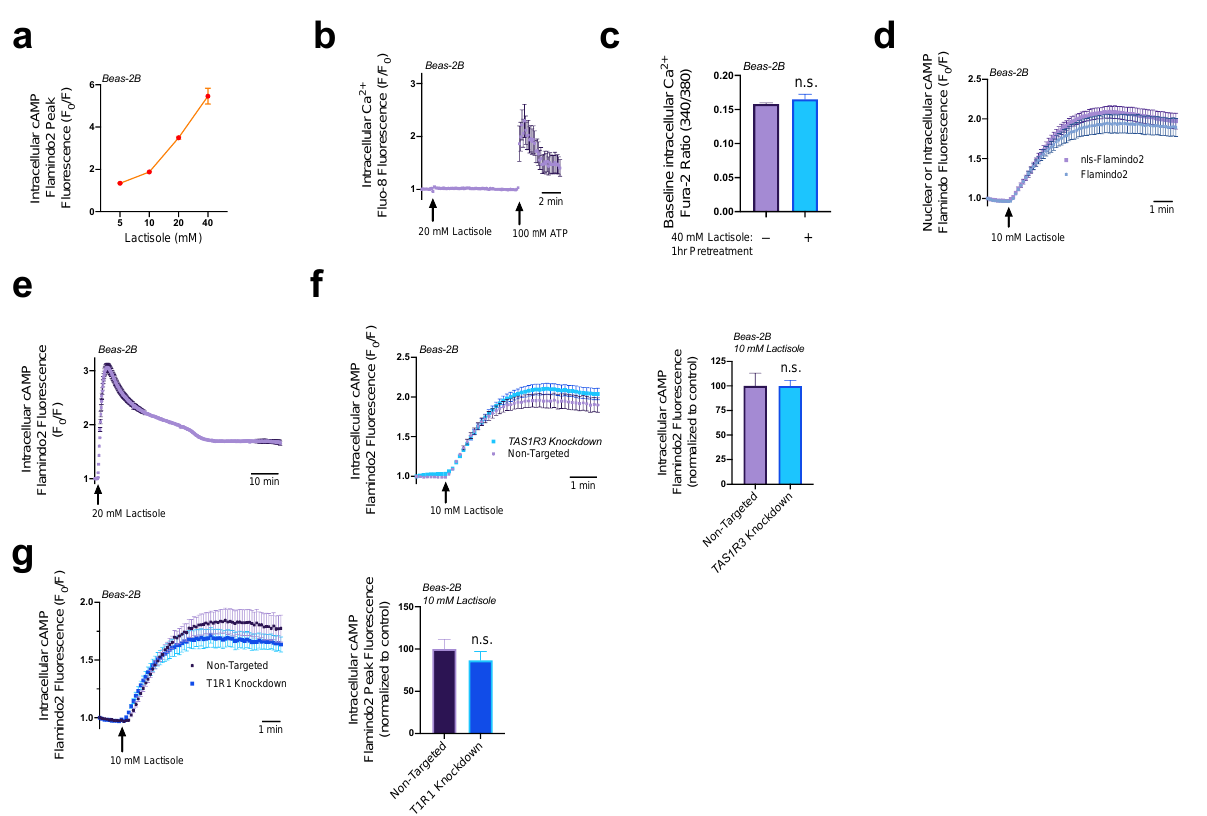
Figure 1. Lactisole stimulates intracellular cAMP elevations. ( a ) Beas-2Bs expressing cAMP biosensor Flamnido2 show a dose-dependent increase in cAMP in response to 5 – 40 mM of lactisole. ( b ) The 20 mM lactisole does not increase intracellular Ca 2+ in Beas-2Bs ( c ) Beas-2Bs treated with 40 mM lactisole for 1 h show no difference in baseline intracellular Ca 2+ as measured by Fura-2 fluorescence. ( d ) The 10 mM lactisole increases both intracellular and nuclear cAMP in Beas-2Bs. ( e ) cAMP elevations lasting for an hour from lactisole treatment. ( f ) There were no significant differences in lactisole-induced cAMP elevations in either T1R3 knockdown or non-targeted control cultures. ( g ) Knocking down T1R1 also had no significant impact on lactisole-mediated cAMP elevations. Traces are representative results from ≥3 experiments. Bar graphs show mean ± SEM from ≥3 experiments. Significance determined by t -test, “ n.s. ” represents no significance.